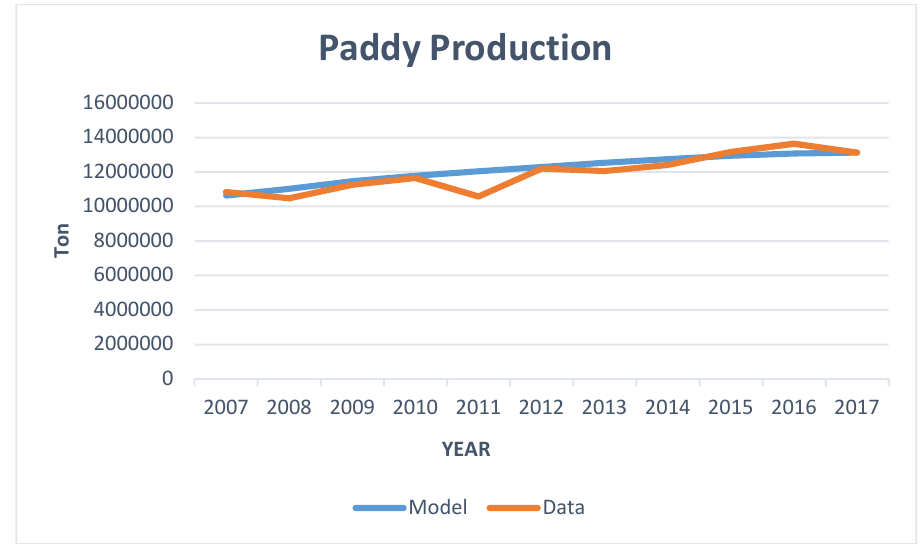
Fig.4 Model validation of paddy production